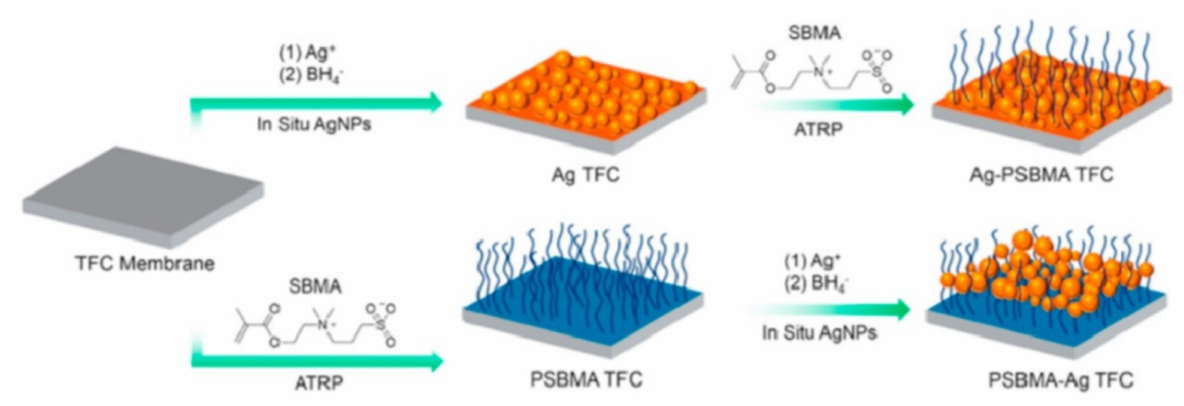
Figure 9. Fabrication process of an antimicrobial TFC membranes used for water treatment. Reprinted from [124] with permission from